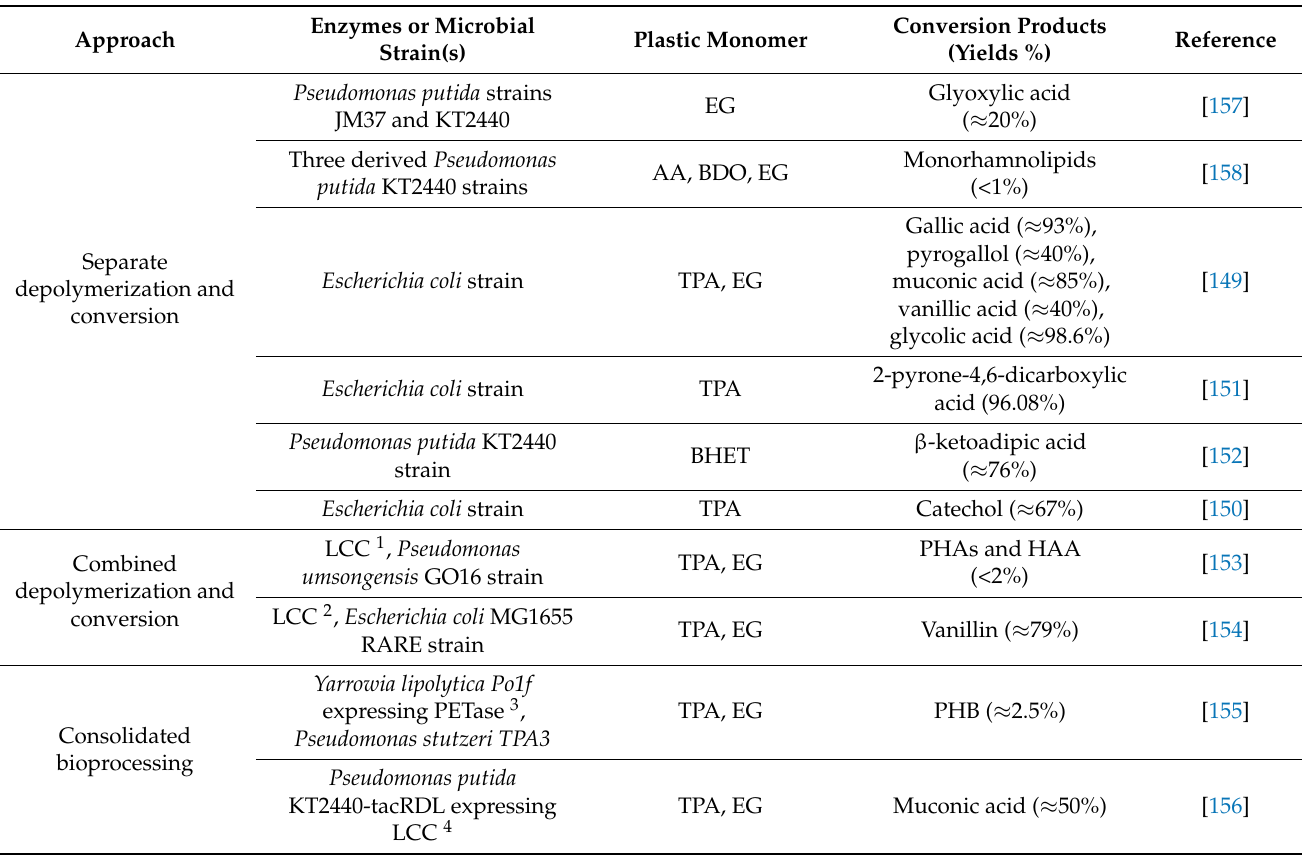
Table 5. List of recent open-loop microbial conversion attempts starting from PET and polyester- PUR degradation products. The different approaches are distinguished with respect to the processing strategies proposed in [36]. Abbreviations: EG—ethylene glycol, AA—adipic